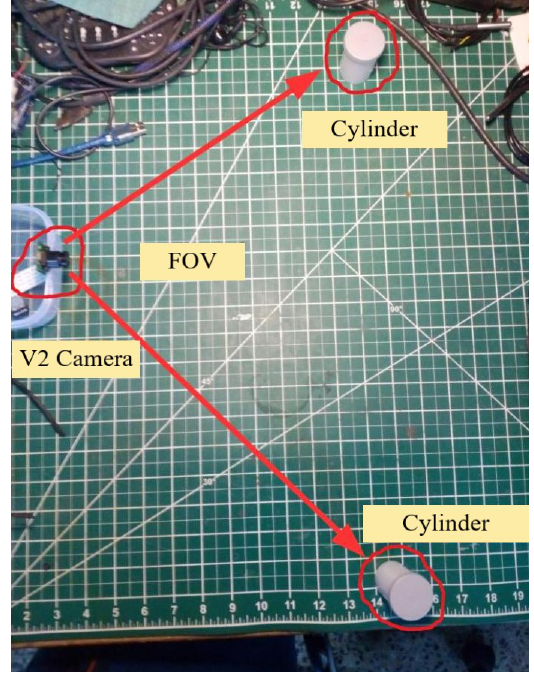
Figure 7. Testing the geometry field of view.